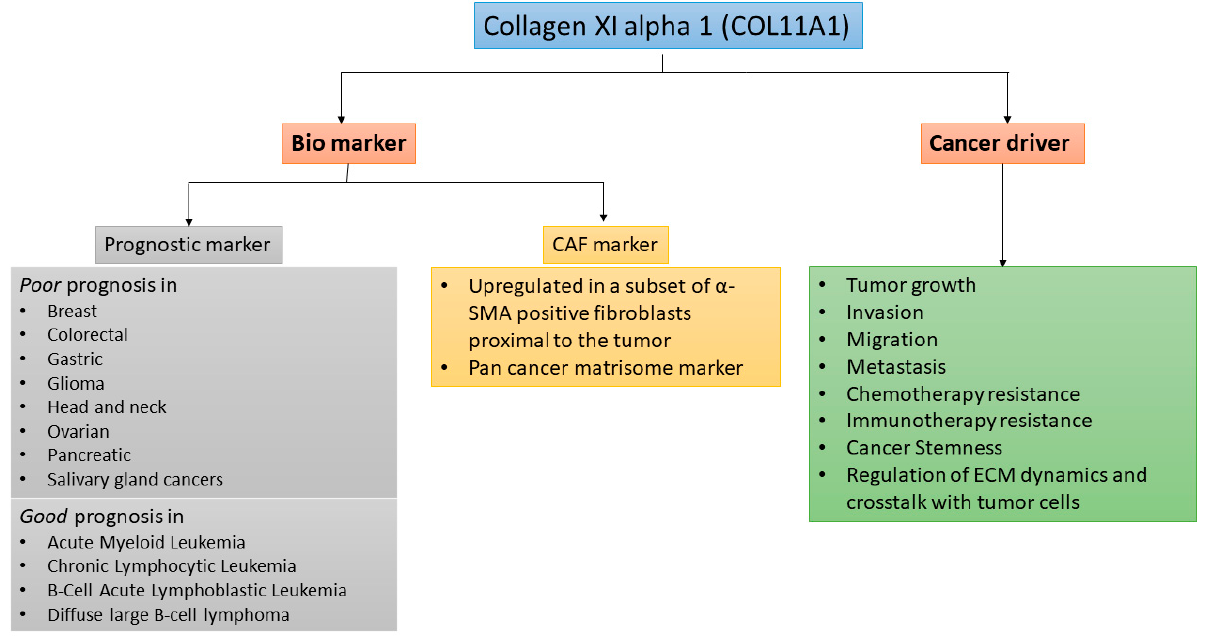
Figure 1. COL11A1 is a biomarker and is driver of aggressiveness in